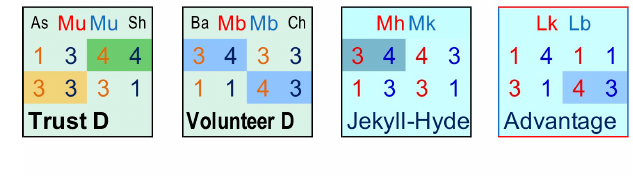
Fig. 4. Payoff matrices for additional intermediate